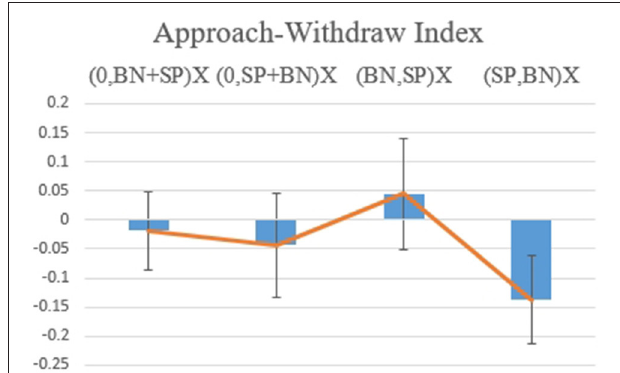
FIGURE 12 | Value for the Approach Withdraw Index for (0, BP + SN), (0, SN + BP), (BP, SN), and (SN, BP).